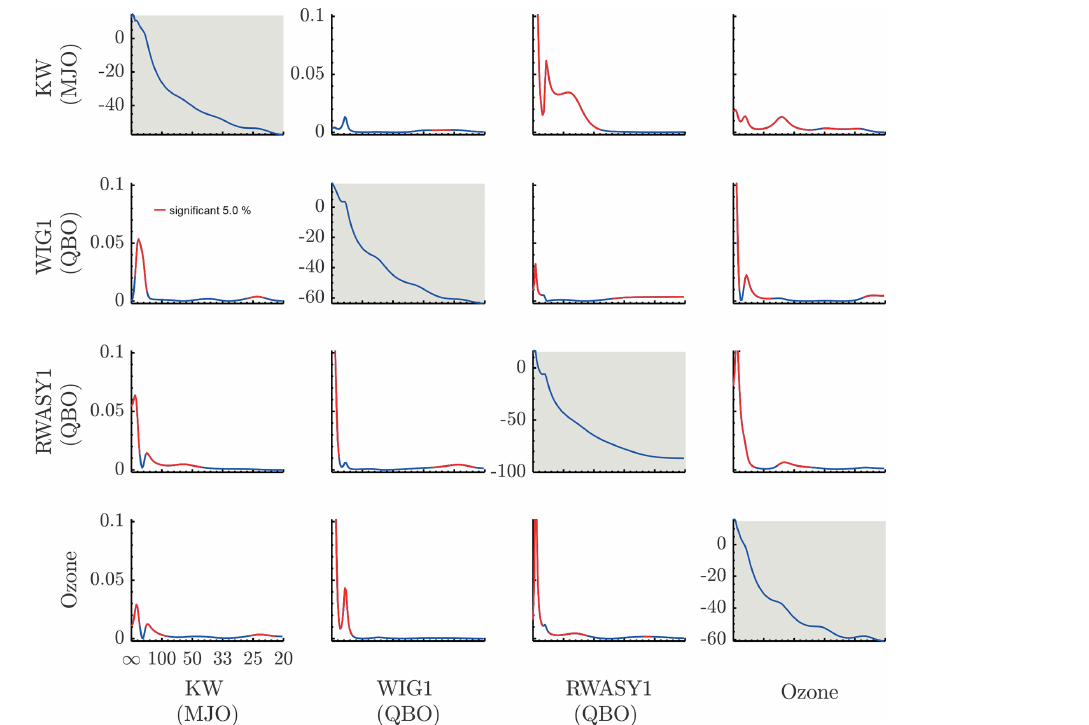
Figure 5. PDC analysis of the interaction of symmetric Rossby n = 1, asymmetric Rossby n = 1, and westward gravity modes with ozone at the fast timescale (periods given in days). Again, significant interactions (red curve) between the MJO and ozone as well as QBO-related modes is found on intraseasonal, semi-annual, and annual timescales. Figure conventions are the same as in Fig. 4.